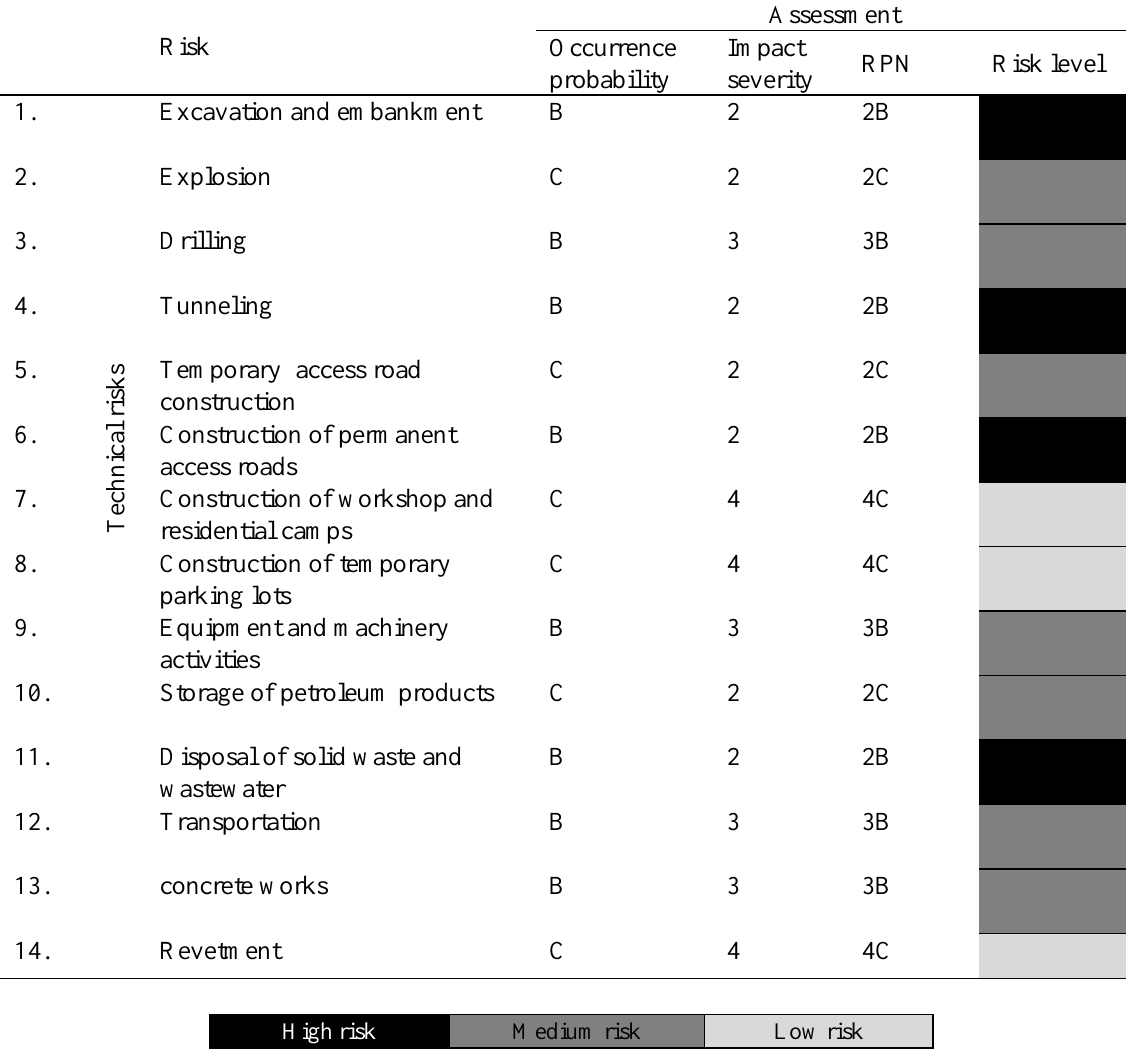
Table 6. PHA of Paveh Rood